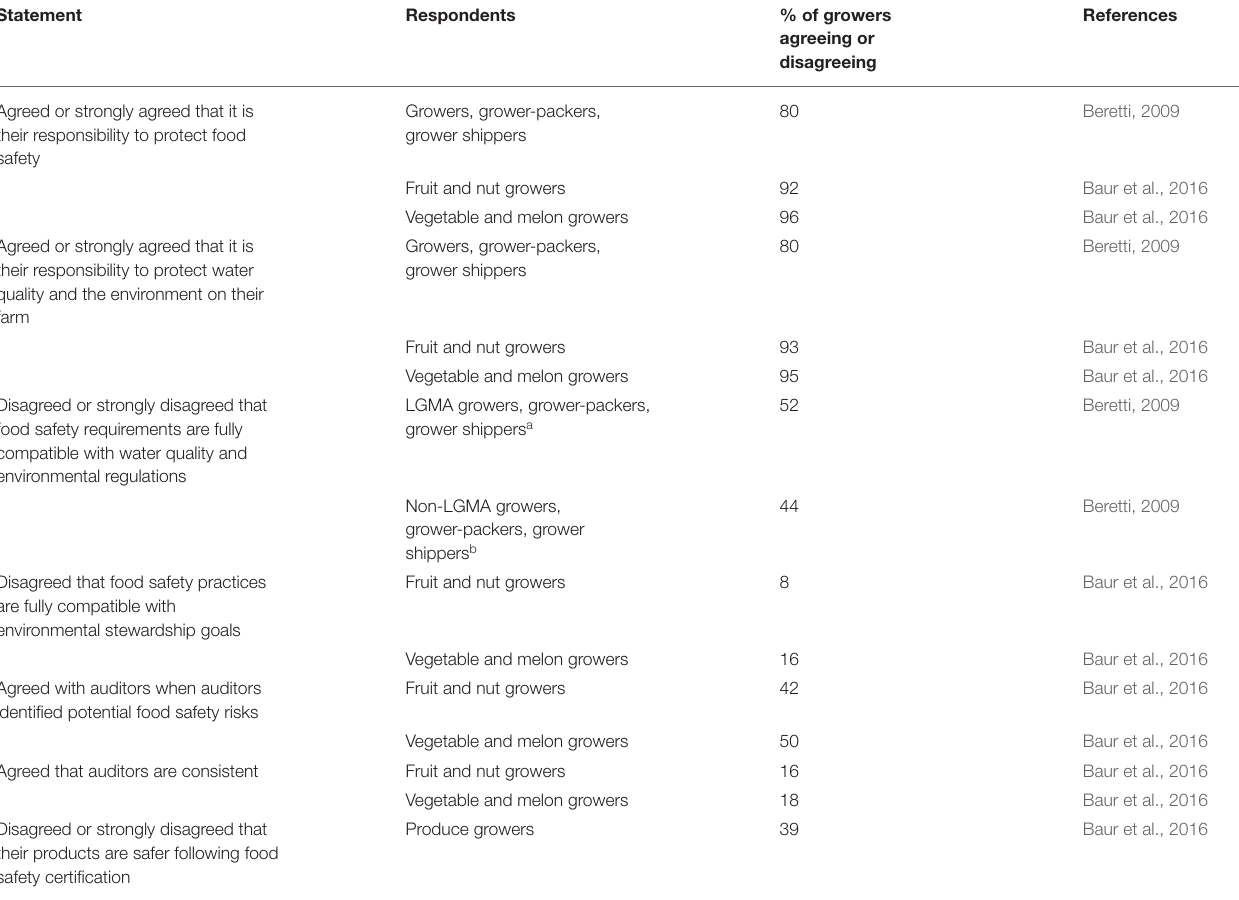
TABLE 3 | Percent of growers agreeing or disagreeing with statements relevant to food safety and environmental